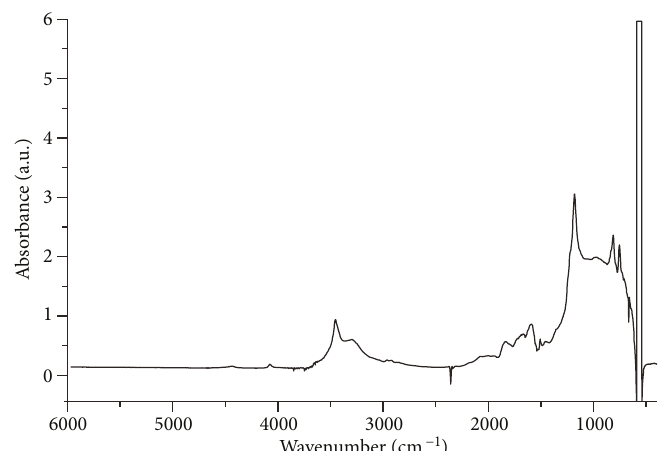
Figure 1: Micro-FTIR spectrum of charoite collected at room temperature in the range 6000 – 400cm − 1